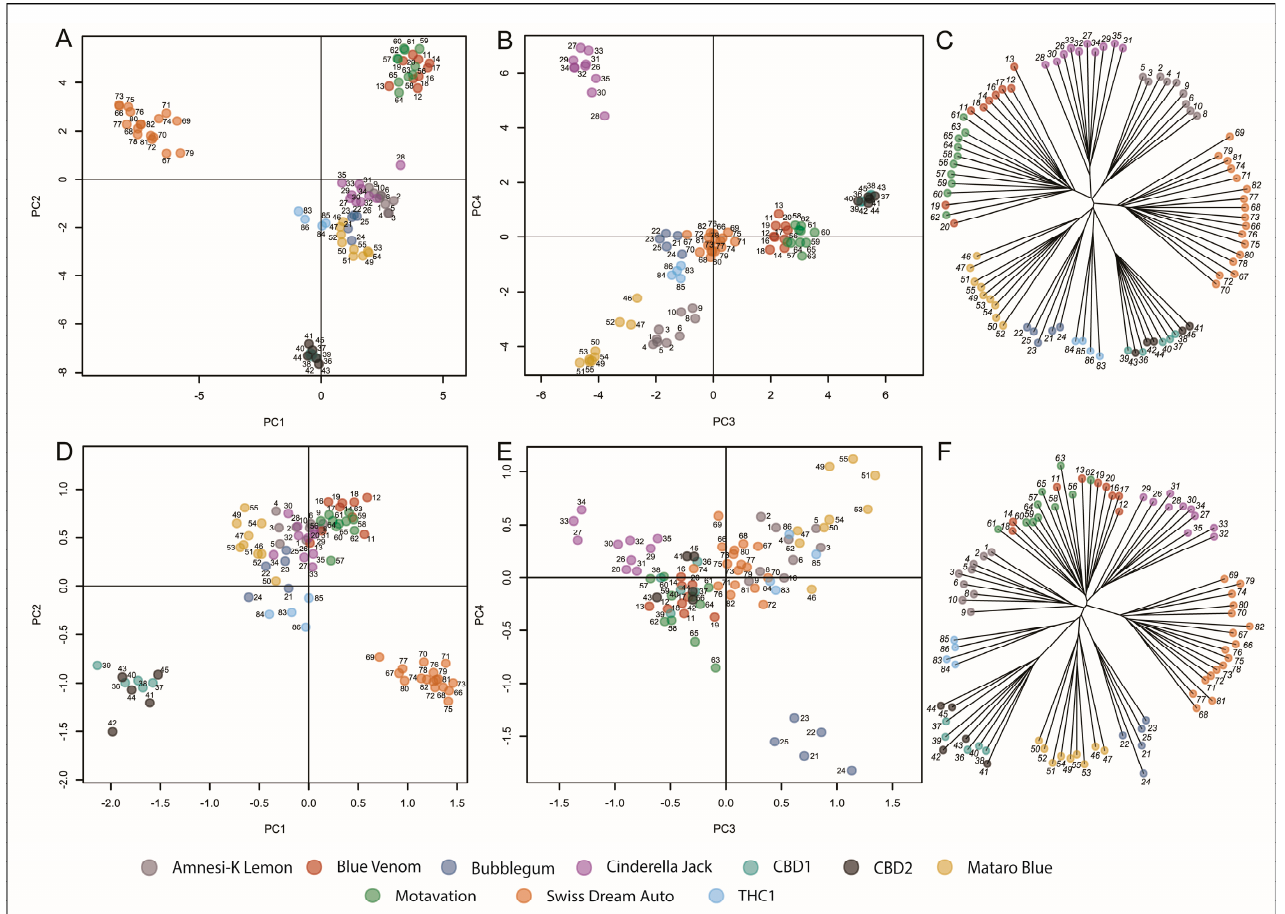
Figure 4. Principal component and phylogenetic analysis of 83 individual Cannabis plants. ( A ) PC1 and PC2 of the entire 3608 SNP dataset generated 4 distinct clusters. The central cluster of multiple varieties is resolved on PC3 and PC4 ( B ), with 8 clusters resolved on a phylogenetic tree ( C ). PCA of a reduced set of 172 SNPs shows variety grouping across ( D ) PC1/PC2 and ( E ) PC3/PC4 axes, as well as to produce the same 8 variety clusters as identified using the full 3608 SNP set in a phylogenetic analysis ( F ).